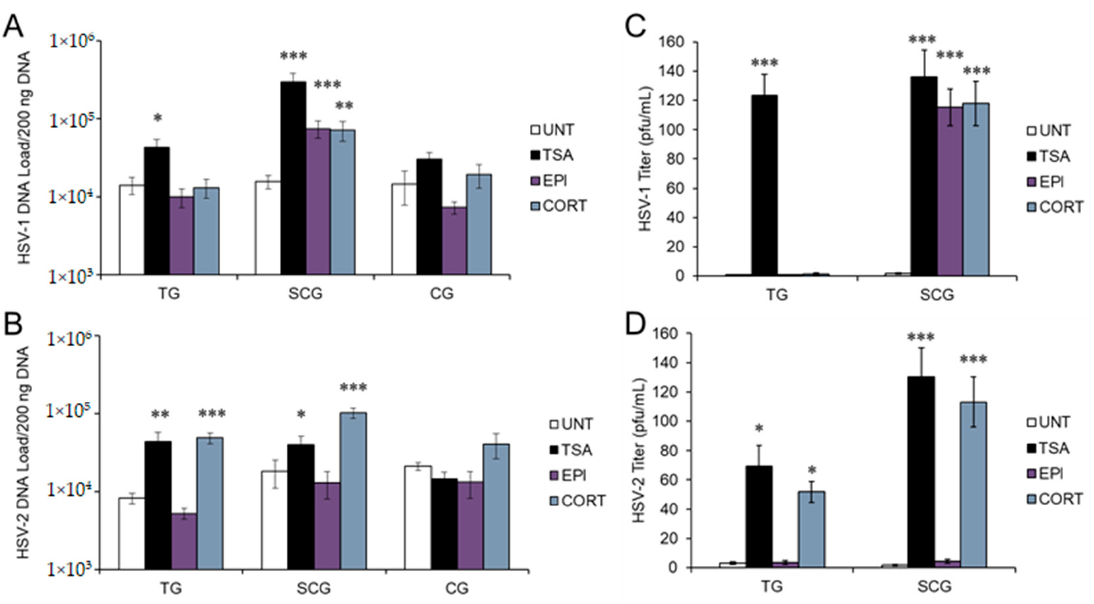
Figure 1. EPI and CORT induce HSV-1 and HSV-2 reactivation selectively in sensory, sympathetic, and parasympathetic neurons. Primary adult neuronal cultures from sensory trigeminal (TG), sympathetic superior cervical (SCG), and parasympathetic ciliary ganglia (CG) were infected with HSV-1 or HSV-2 in the presence of acyclovir for 7 days, followed by treatment with epinephrine (EPI; 10 µM), corticosterone (CORT; 10 µM), or trichostatin A (TSA; 1.2 µM), compared to untreated (UNT) neurons. HSV-1 ( A ) and HSV-2 ( B ) viral DNA was quantified by qPCR 24 h post-reactivation. In parallel, HSV-1 ( C ) and HSV-2 ( D ) infectious viral titers were quantified by plaque assay on Vero cells 24 h posttreatment. Data are shown as means ± SEM, n > 6; results were compared to untreated cultures by ANOVA and post hoc Tukey’s HSD; * p < 0.05; ** p < 0.01; *** p < 0.001.